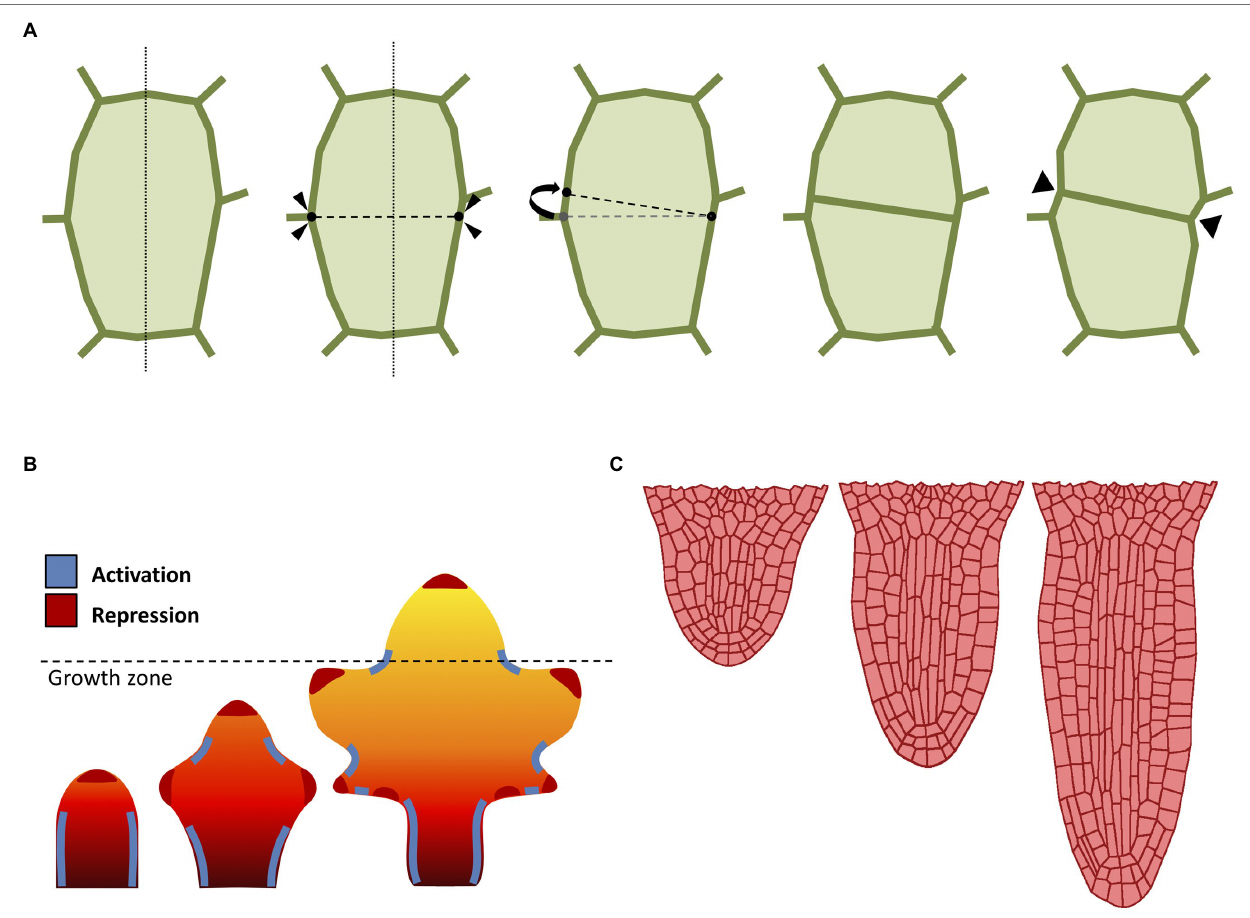
FIGURE 2 | Computational approaches to cell division and growth. (A) A popular implementation of cell division rule. The cell wall is represented as a polygon of vertices connected by edges. According to the shortest-distance rule (Errera, 1888), the cell is divided by identifying the shortest division plane cutting through the cell. To avoid conflict with existing vertices, the two ends of the division plane can be spread apart by a minimal threshold distance. Cell division splits the cell into two daughter cells yielding two new connected vertices in the cell wall. Often, the cell wall is “pinched” along the newly created vertices (Smith et al., 2006b). (B) Computational model of leaf shape development (adapted from Runions and Tsiantis, 2017). Mature leaf shape is achieved through the interaction between three components: a proximal-distal hypothetical morphogen and two master regulators. The basipetal red-orange-yellow gradient region defines the action of the growth morphogen (red: higher growth, yellow: lower growth), where the dashed line indicates the border between the actively growing region and the differentiation zone. The marginal patterning of the leaf blade is the result of the combined action of a local growth activator (red) and a growth suppressor (blue). (C) Computational model of radicle emergence (adapted from Marconi et al., 2021). This simulation reproduces the embryonic emergence of the root meristem of Arabidopsis . Organ growth follows the combined action of cell elongation, cell division, and tissue mechanics. Note that the organ maintains a distinct anisotropic form through the self-organization of cortical microtubules despite each single cell being expanded by uniform turgor pressure (see Marconi et al., 2021 for